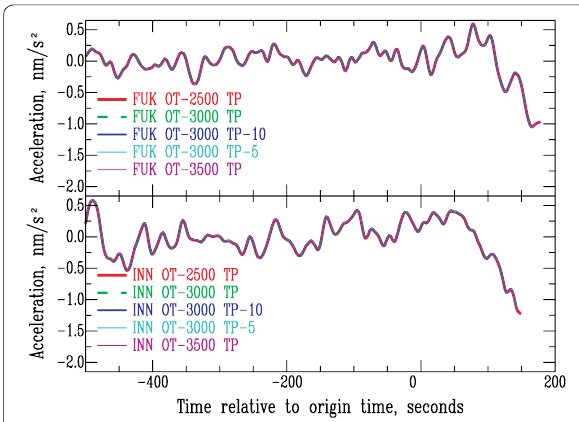
Fig. 2 Robustness of the V17 data processing illustrated for two stations of the F‑net network. FUK (top) and INN (bottom) are STS1 and STS2 sensors, respectively. For each sensor, the curves show the obtained vertical acceleration signals for different choices of the original time window. These choices can be read in the name given to each curve: the negative number following “OT” gives the starting time (in s) of the window relative to the Tohoku earthquake origin time; the negative number following “TP” gives the ending time (in s) of the window relative to the P‑wave arrival time at each station. No differences can be observed in the resulting accelerations in the 0.002–0.03 Hz frequency